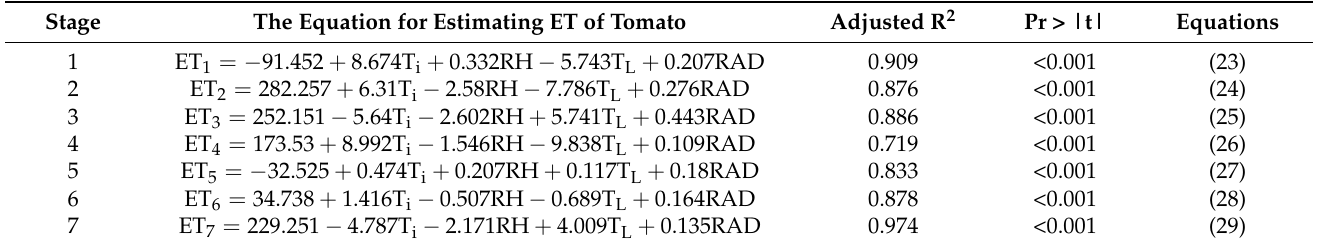
Table 5. Multiple regression model for estimating ET by growth stages.